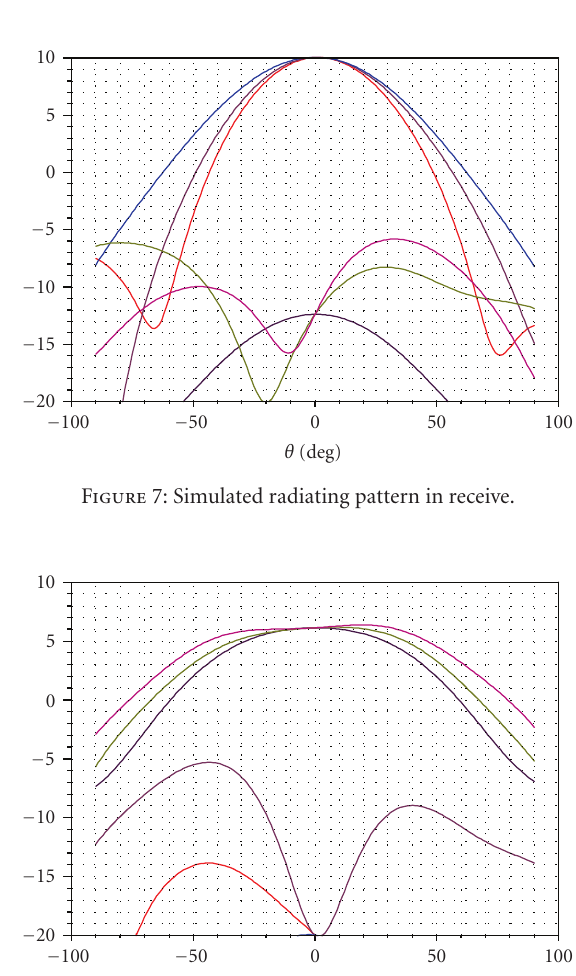
Figure 10: Tx and Rx active device—control board view.